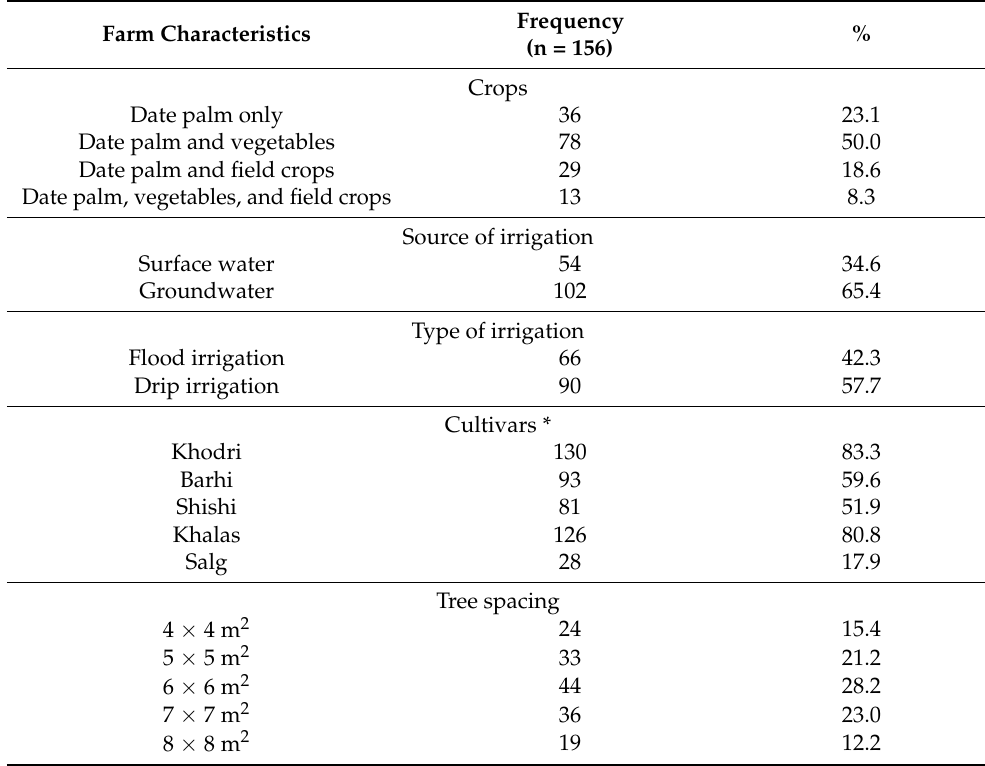
Table 2. Descriptive summary of farm